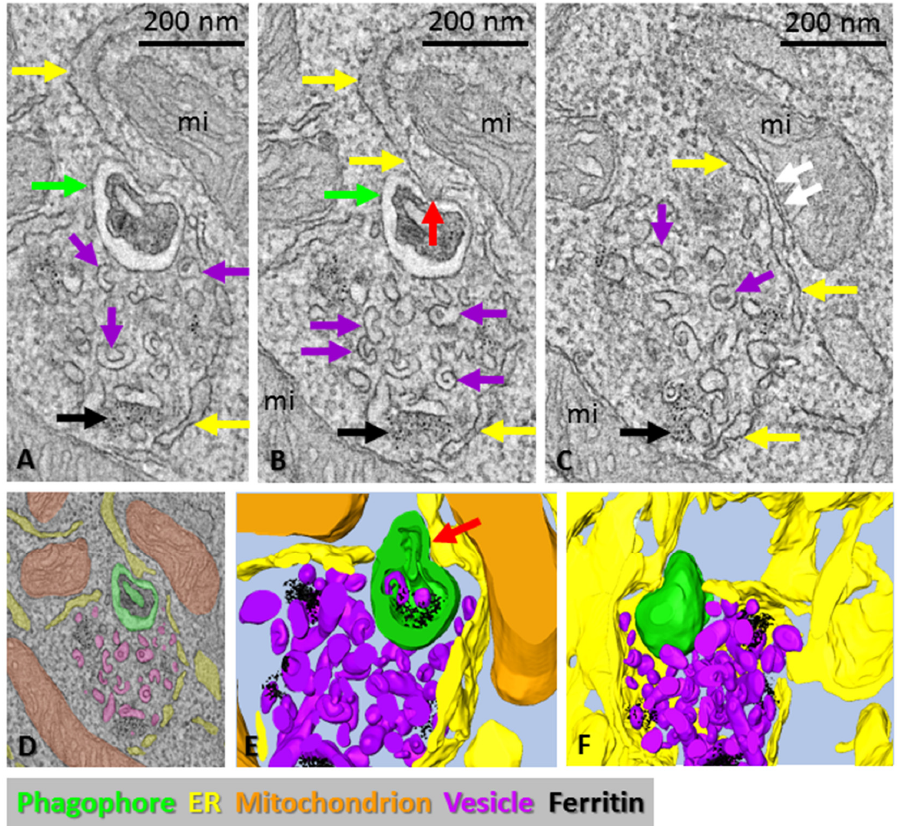
Figure 2. Electron tomography of a mouse embryonic fibroblast deficient in ATG2A and ATG2B. ( A – C ) Tomography slices of a ribosome-free area containing a double-membrane vesicle (a putative phagophore precursor (green arrows)), cup-shaped vesicles (purple arrows), ferritin particles (black arrows) and surrounded by ER (yellow arrows) and mitochondria (mi). The red arrow in panel ( B ) indicates an MCS between the phagophore precursor and the ER, and the white arrows in panel ( C ) point to an MCS between the ER and a mitochondrion. ( D ) Organelles in the tomogram were traced with different colors, as indicated by the overlay, as well as the bottom panel of the figure. ( E , F ) Details of the 3D model. Ferritin particles are shown in black. Note the MCS between the phagophore precursor and ER (red arrow), also visible in panel ( B ). The phagophore precursor contains ferritin and two